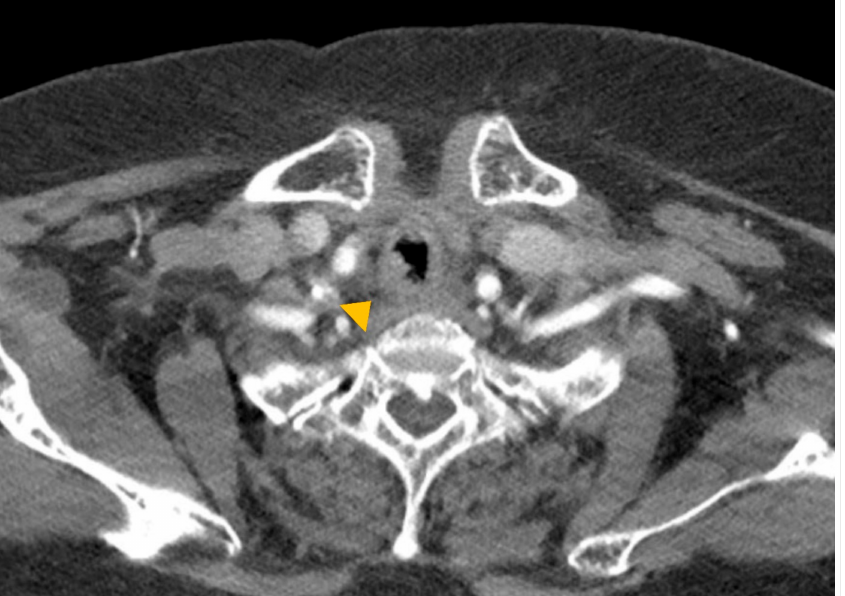
Figure 1. Neck computed tomography image. A diffuse wall thickening and intraluminal irregularity are noted in the proximal trachea (arrowhead).